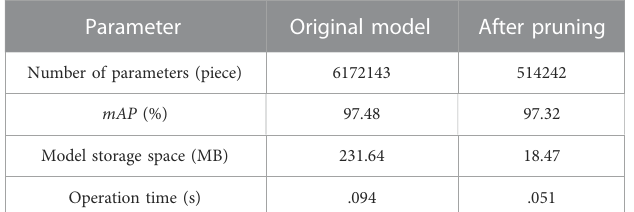
TABLE 4 Parameters after fi ne